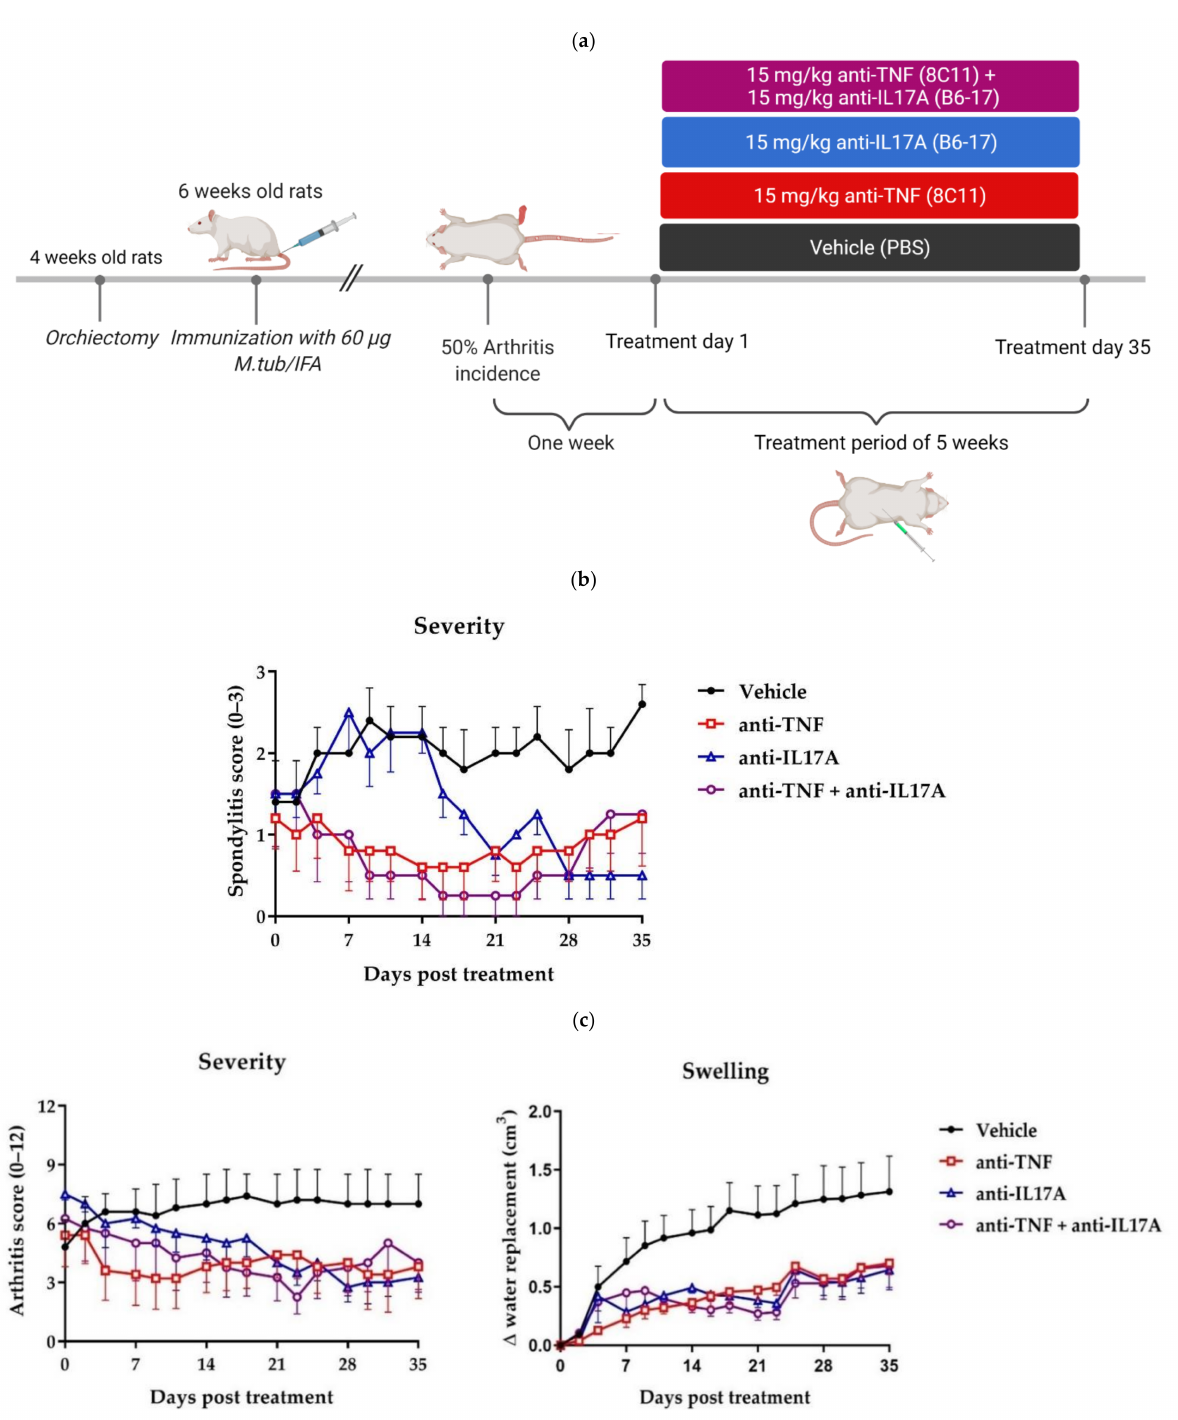
Figure 1. Tumor necrosis factor (TNF) and interleukin-17A (IL-17A) dual blockade therapy reduces axial and peripheral clinical disease. ( a ) Study design. Male HLA-B27/hu β 2m transgenic rats were orchiectomized at four weeks of age and immunized with 60 µ g Mycobacterium tuberculosis ( M. tub. ) at six weeks of age. One week after arthritis incidence reached 50%, the rats were randomized according to arthritis severity to be treated twice weekly with intraperitoneal injections with either 15 mg/kg anti-TNF and 15 mg/kg anti-IL-17A (8C11 and B6-17, n = 4), 15 mg/kg anti-TNF (8C11, n = 5), 15 mg/kg anti-IL-17A (B6-17, n = 4), or PBS as vehicle control ( n = 5) for five weeks. An experimentally blinded observer scored spondylitis severity (0–3 per tail), and peripheral